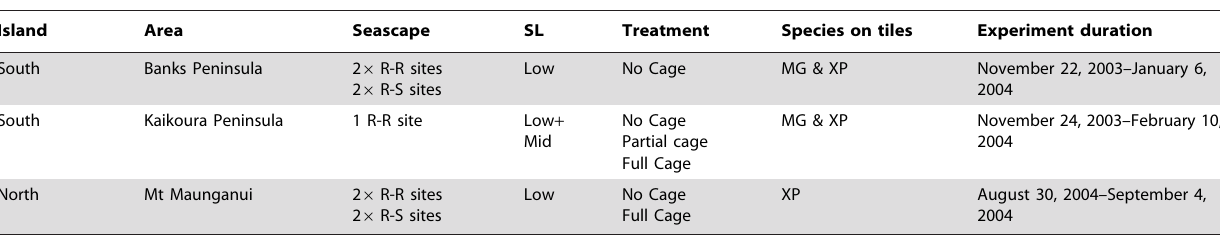
Table 1. Design of predation